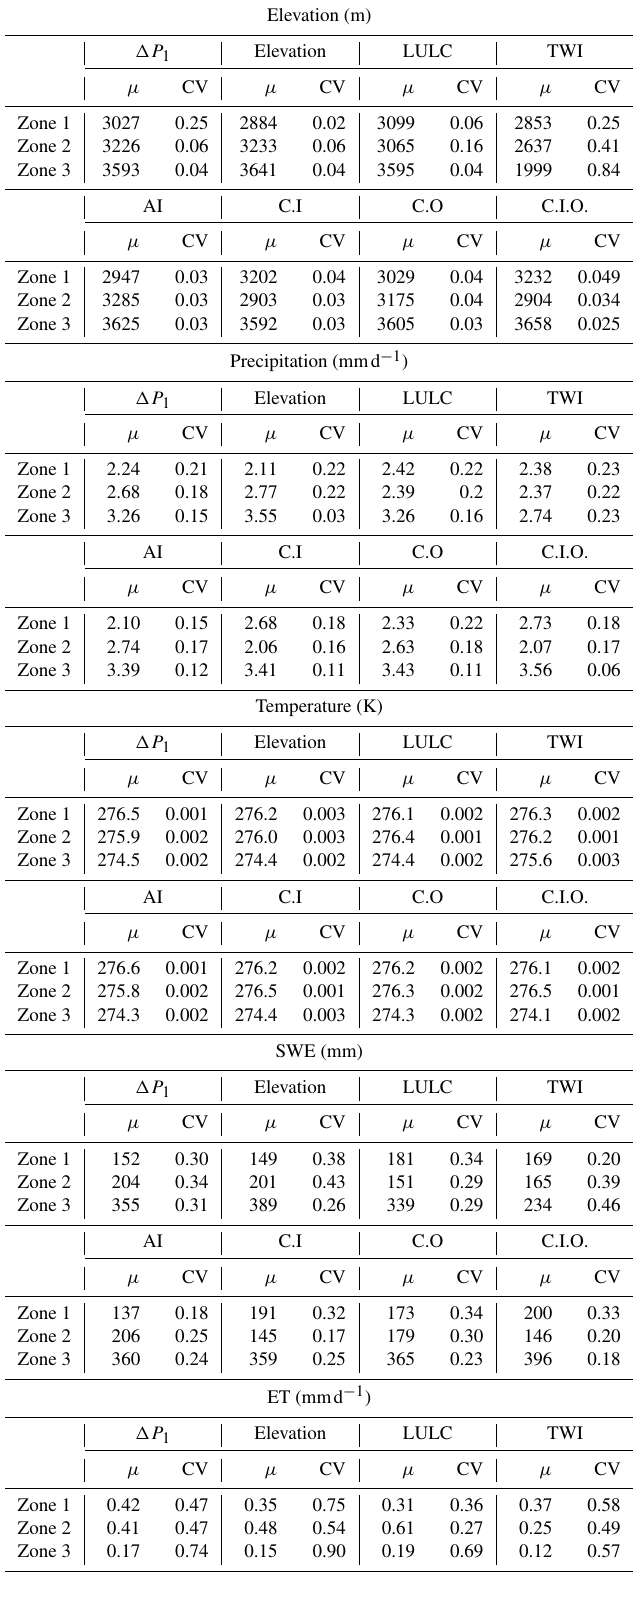
Table 1. Mean µ and coefficient of variation CV of each variable and hillslope zone derived from the eight clustering approaches. LULC stands for land cover and land